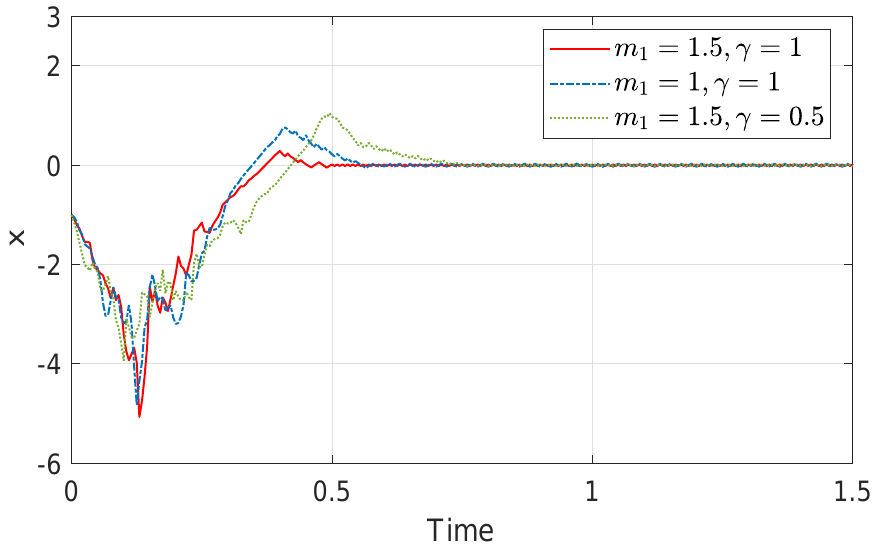
Figure 5. The trajectories of x 2 ( t )